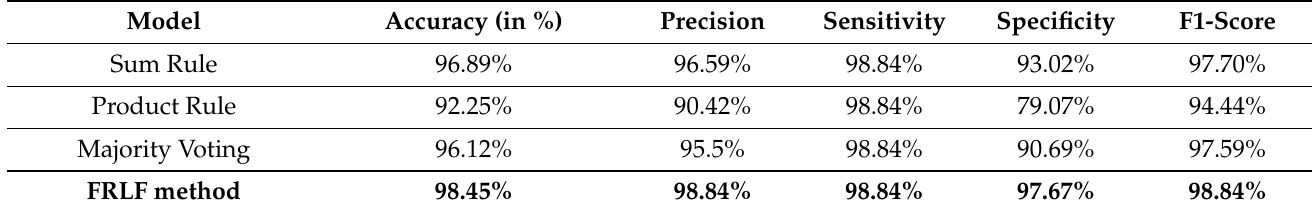
Table 4 reflects the results obtained after applying these ensemble techniques. Table 4. Results obtained after applying different ensemble